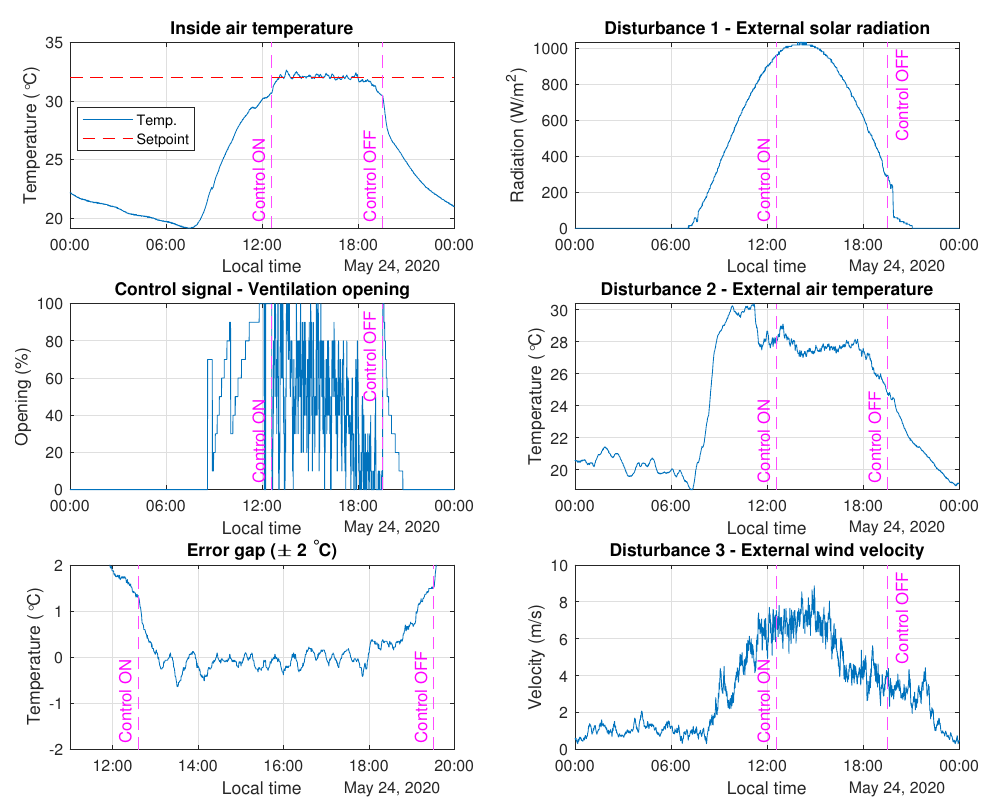
Figure 15. Real control test from 24 May 2020. All the feedforward compensators were